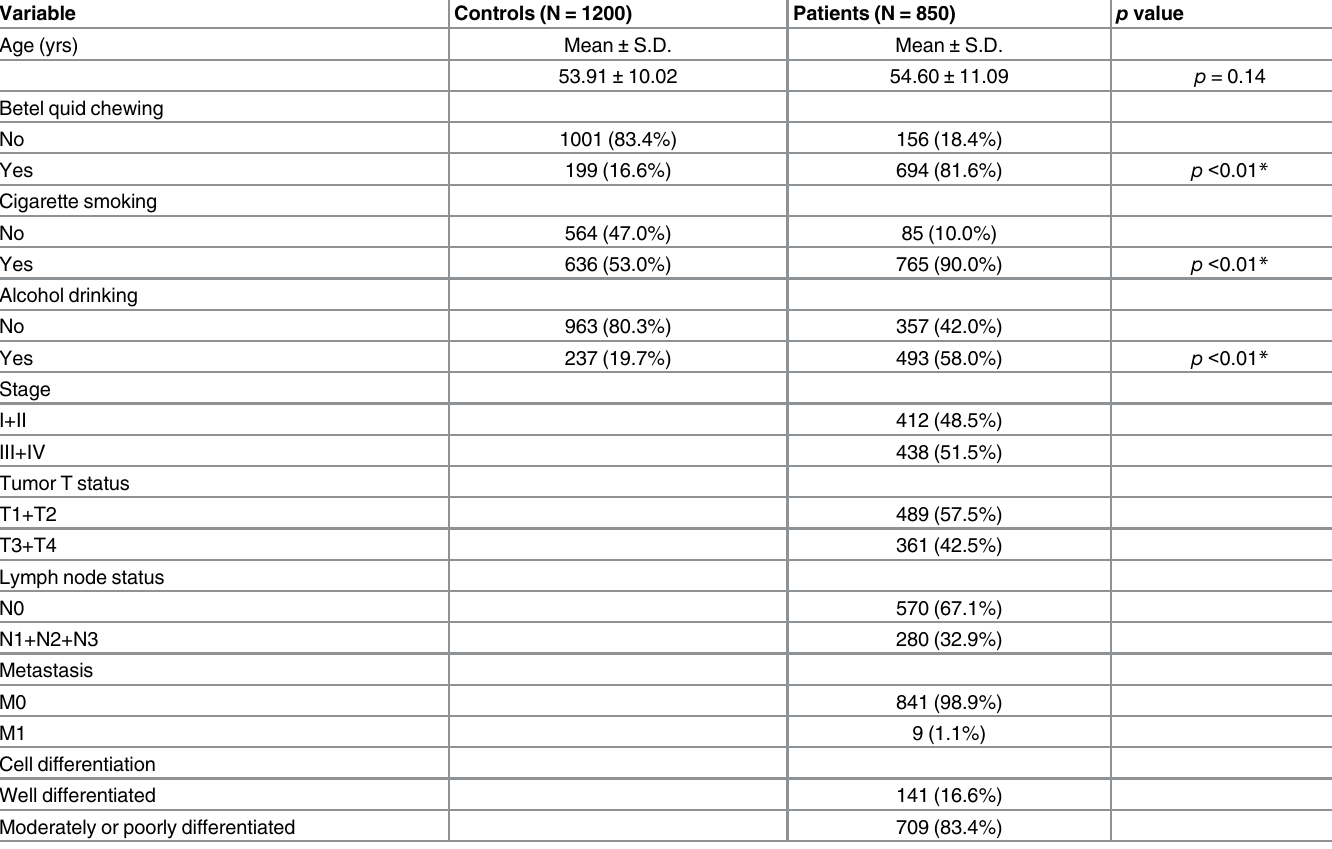
Table 2. The distributions of demographical characteristics in 1200 male controls and 850 male patients with oral